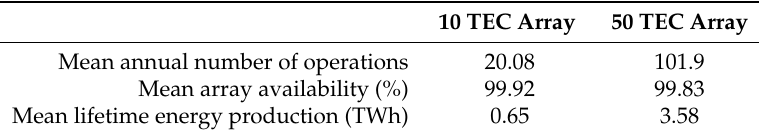
Table 8. DTOcean simulations’ maintenance